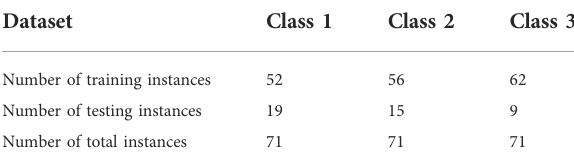
TABLE 11 Numbers of training and testing instances of the Wine